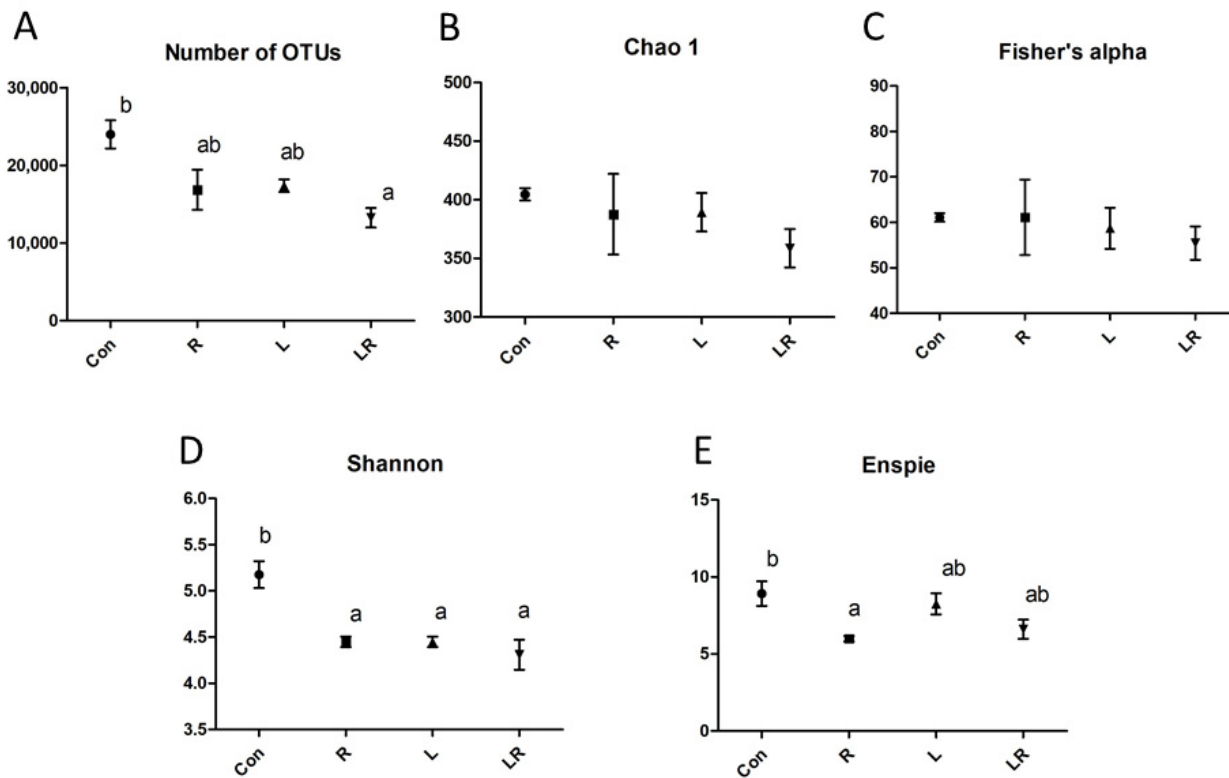
Figure 1. Sample information and microbial diversity in the cecum of laying hens. ( A ) Number of OTUs, ( B ) Chao 1, ( C ) Fisher’s alpha, ( D ) Shannon, ( E ) Enspie. Con, basal diet; R, control plus 0.6% Hydrastis canadensis root; L, control plus 0.6% Hydrastis canadensis leaf; LR, control plus 0.6% Hydrastis canadensis root and leaf. Data are expressed as mean ± SEM. Symbols indicate statistical significance. Different letters indicate p -value ≦ 0.05.